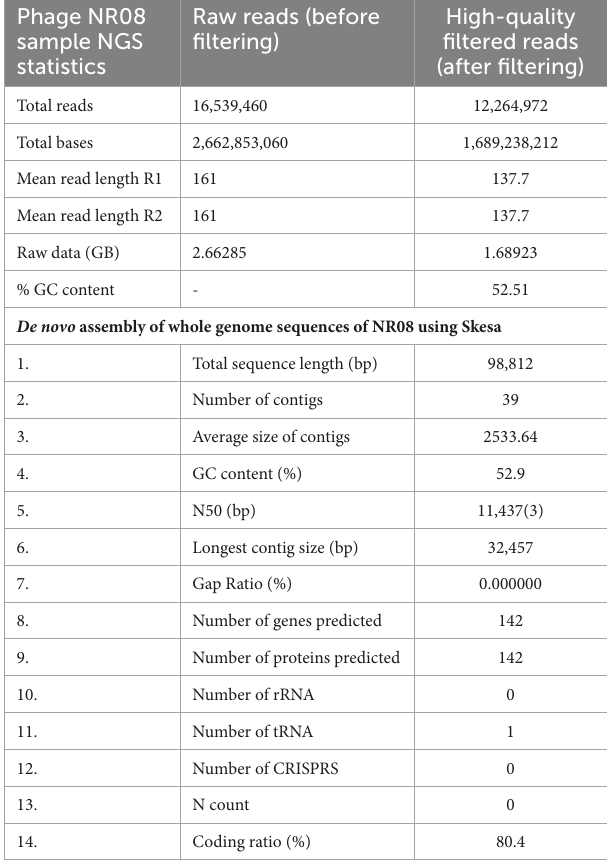
TABLE 3 NGS sequencing read statistics of raw reads and filtered reads and de novo assembly of whole-genome sequences of NR08 using SKESA assembler.